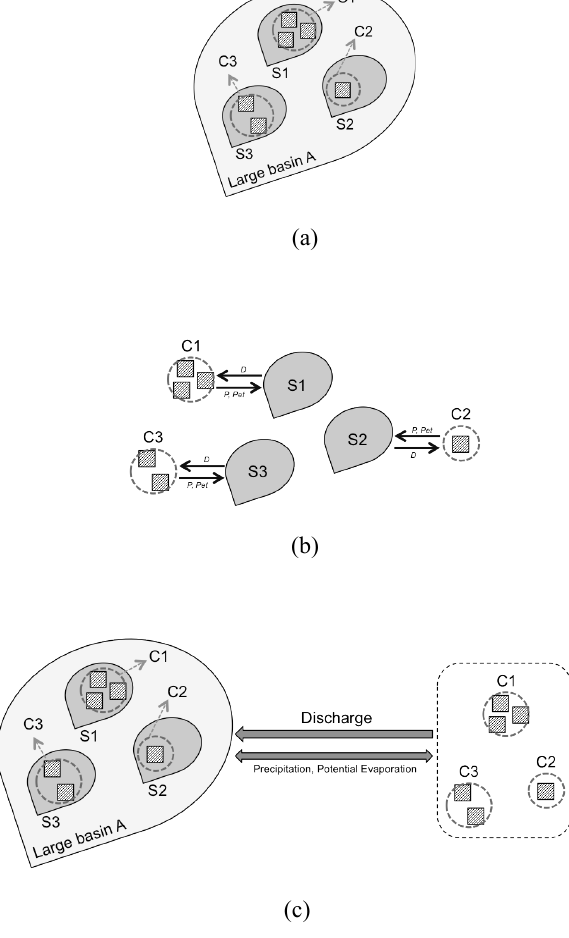
Figure 4. Schematic illustration of the scale-extrapolation method. 9 Fig. 4. Schematic illustration of the scale-extrapolation method. (a) An ungauged large basin A and its gauged sub-basins S 1 , S 2 4(a): An un-gauged large basin A and its gauged sub-basins S 1 , S 2 and S 3 , each contains a 10 and S 3 , each containing a group of cell C 1 , C 2 and C 3 , respectively. (b) Cell groups C 1 , C 2 and C 3 can well resemble essential climate group of cell C 1 , C 2 and C 3 respectively. 11 variables of their respective sub-basins; therefore, C 1 , C 2 and C 3 are expected to have same discharge dynamics as their respective sub-basins. (c) The combination of all cell groups can well resem- ble essential climate variables of basin A; therefore, area-weighted discharge from all cell groups can be used to estimate the discharge of basin A.